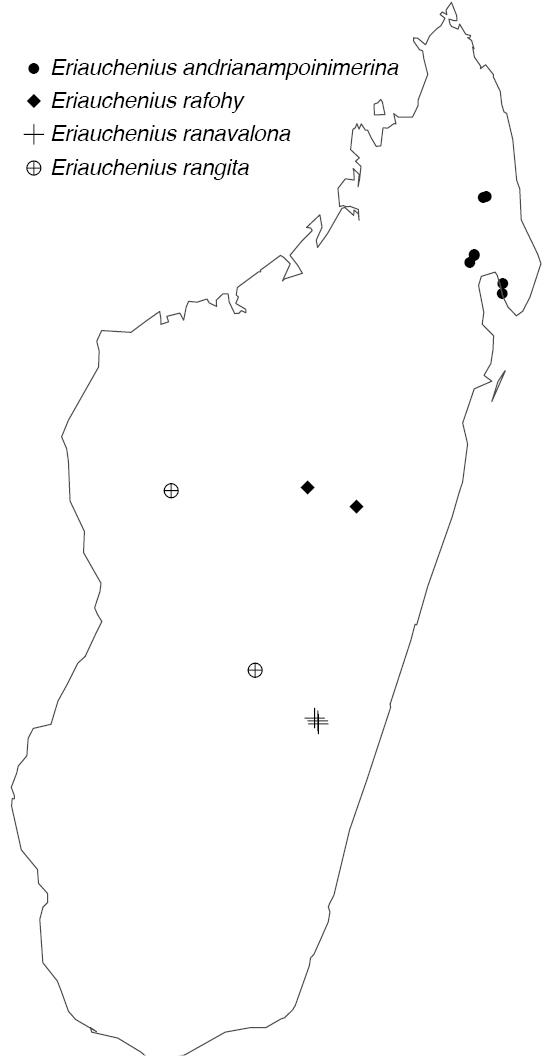
Distribution map for Eriauchenius species.